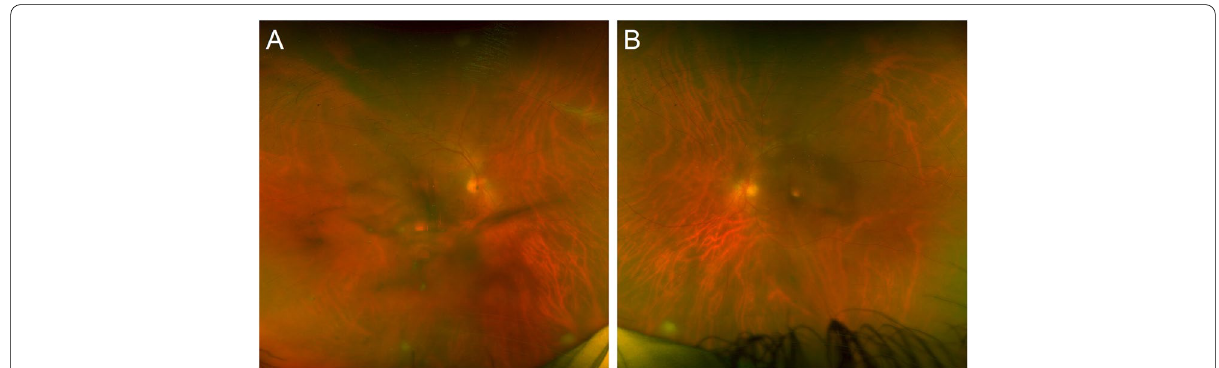
Fig. 1 ( A and B ) Bilateral recurrent endogenous Candida endophthalmitis (ECE) is seen with moderate vitritis and chorioretinal lesions one year after failing systemic and intravitreal antifungal therapy